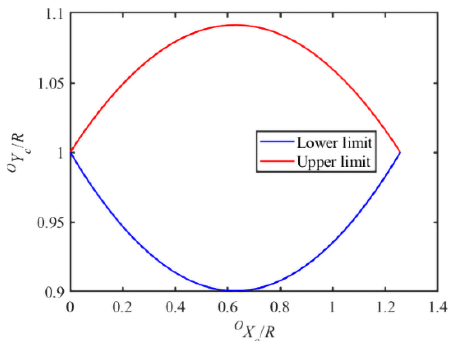
Figure 8. The upper and lower limits of the CoM trajectories.